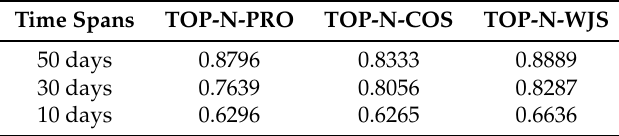
Table 1. Experimental results on different time lengths on GeoLife